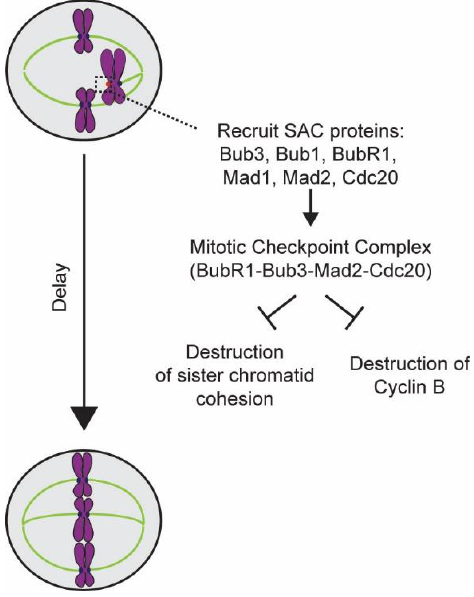
Figure 1. Schematic of the overall design of the spindle assembly checkpoint (SAC).